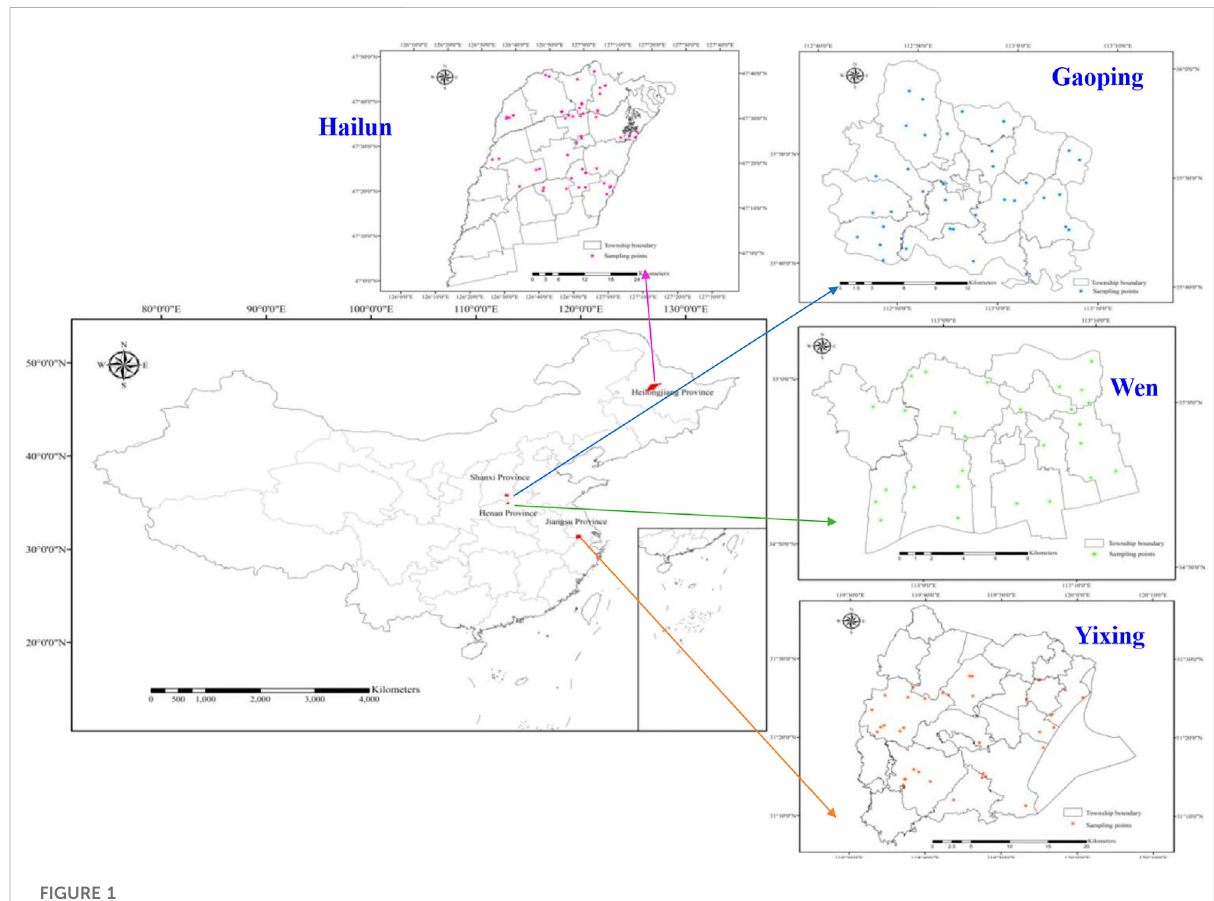
FIGURE 1 Location of the study area and distribution of sampling plots.